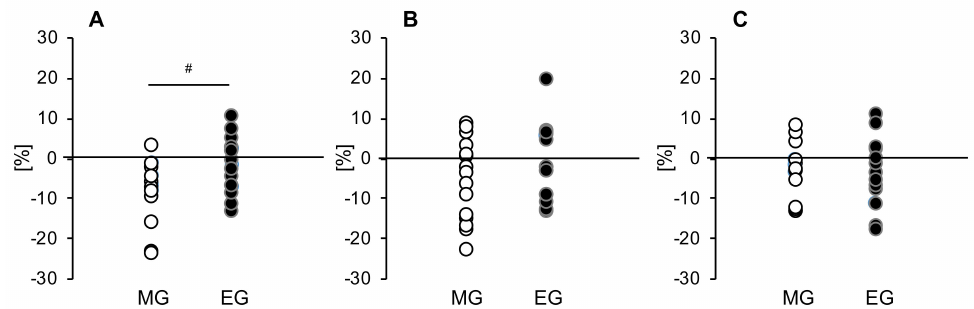
Figure 4. Comparison of the change rates of the peak blood glucose levels after each meal in both groups at ( A ) breakfast, ( B ) lunch, and ( C ) dinner. MG: morning group, EG: evening group. Values are expressed as means and standard errors. # p < 0.05 compared to the level in the evening group (unpaired t